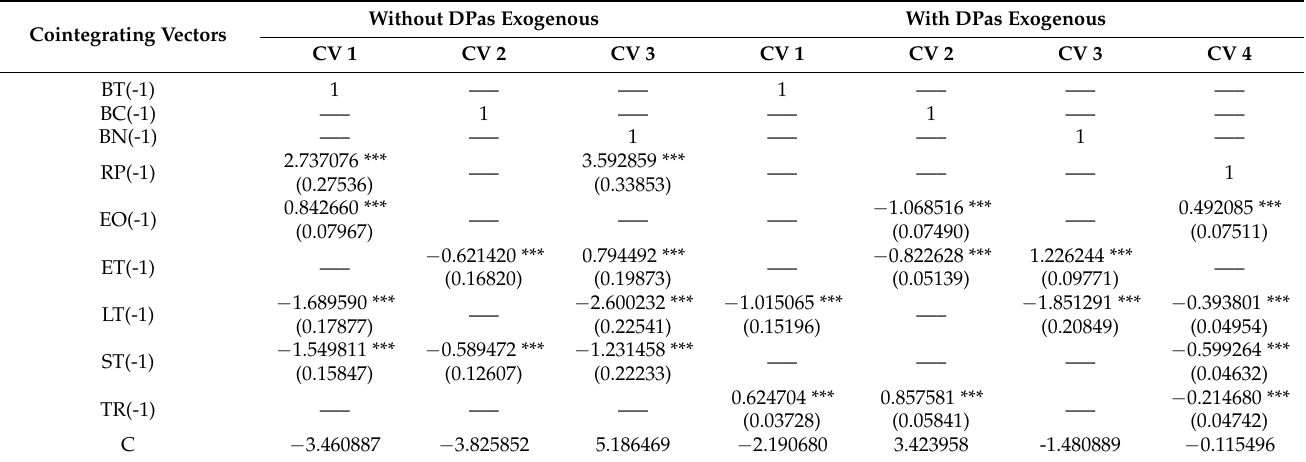
Table 5. Johansen Normalization Restriction